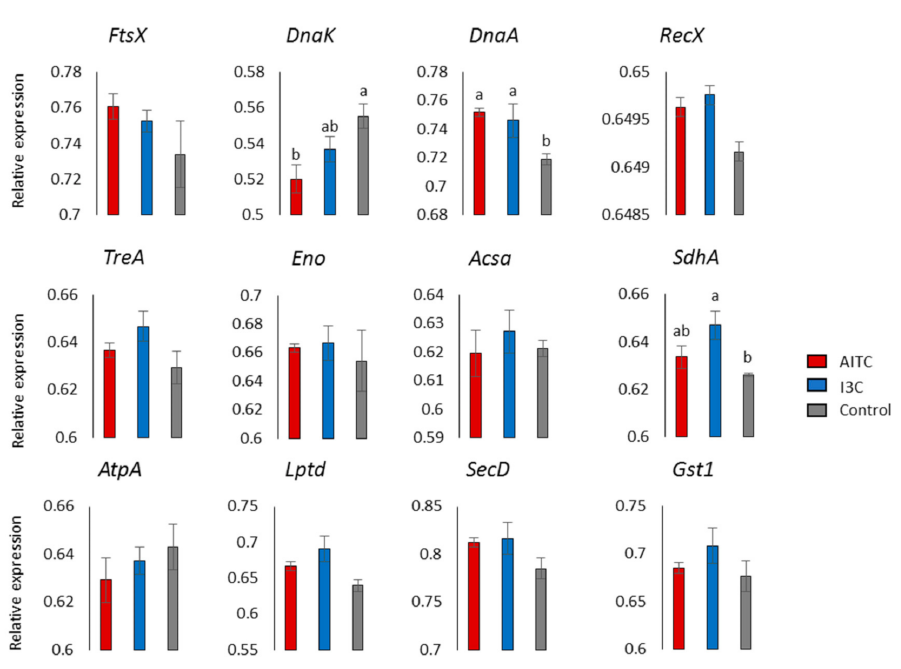
Figure 6. Relative expression patterns of twelve genes from Xanthomonas campestris pv. campestris treated with glucosinolate hydrolysis products and the control. Data are the average of three biological replicates ± SE. Letters at the top of the bars represent significant differences among treatments at p -value <